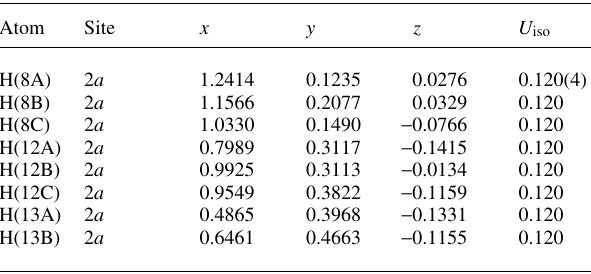
Table 2. Atomic coordinates and displacement parameters (in Å 2 ) .